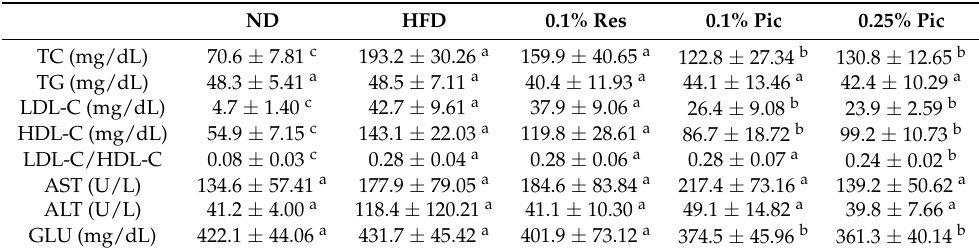
Table 1. Effect of piceatannol supplementation on serum biochemical parameters in HFD-fed C57BL/6 mice. ND HFD